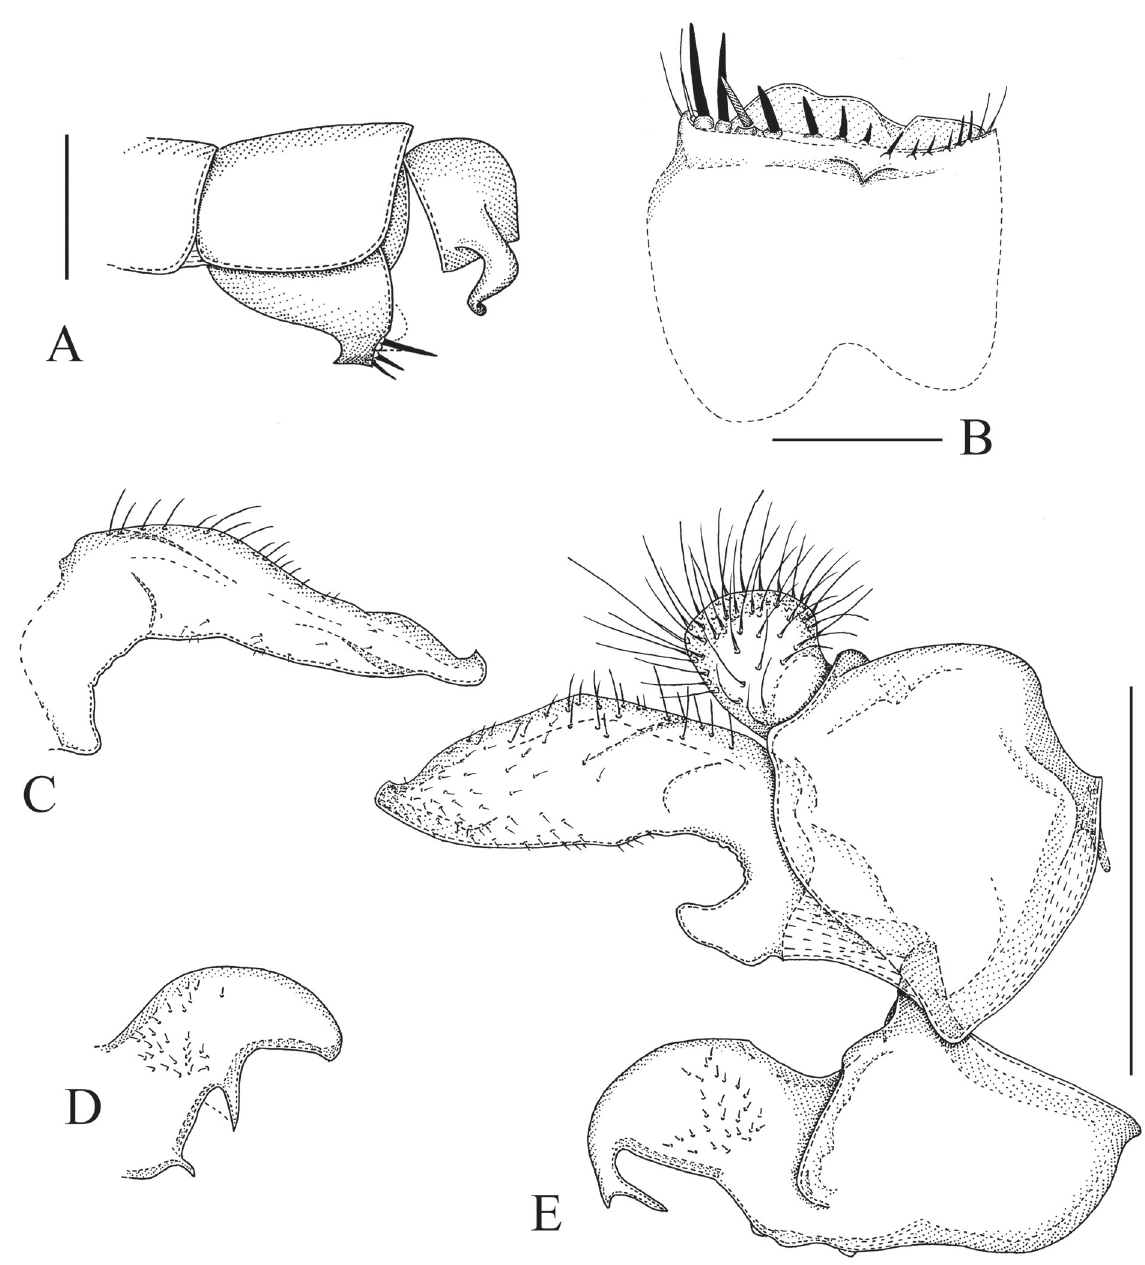
Fig. 85. Sphegina (Asiosphegina) spenceri sp. nov., holotype, ♂ (B–D) and paratype, ♂ (A–B). A . Posterior part of abdomen, left side lateral view. B . Sternum IV, ventral view. C . Left surstylus, lateral view. D . Left superior lobe with associated parts, lateral view. E . Genitalia, right side, lateral view. Scale bars = 0.5